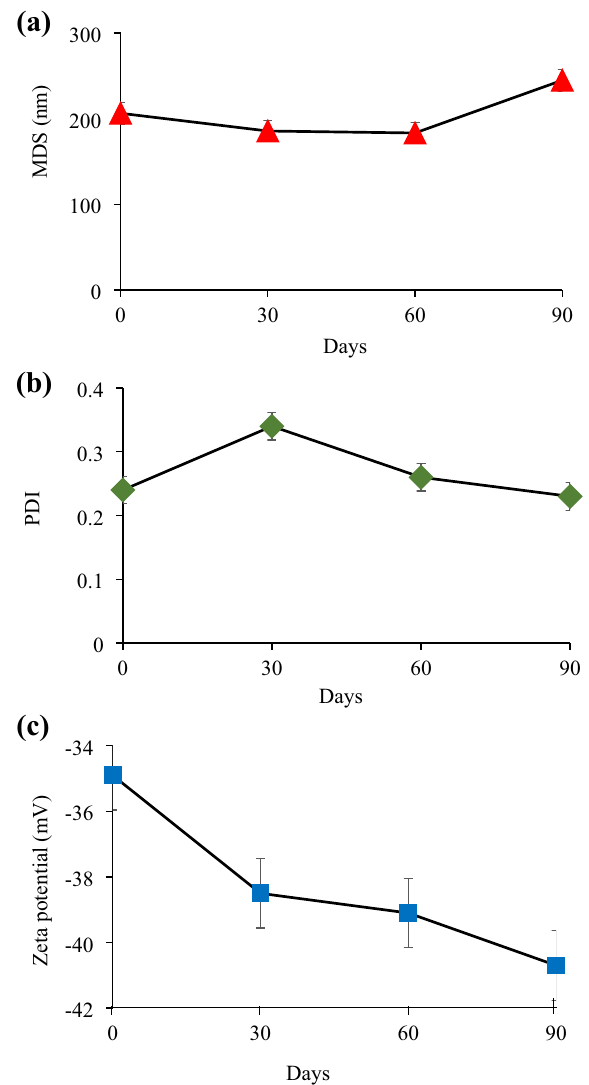
Figure 1. Results of the 90 days storage stability of the optimal nanoemulsion at 25 °C, where plot ( a ) Mean droplet size (MDS), ( b ) Polydispersity index (PDI), and ( c ) zeta